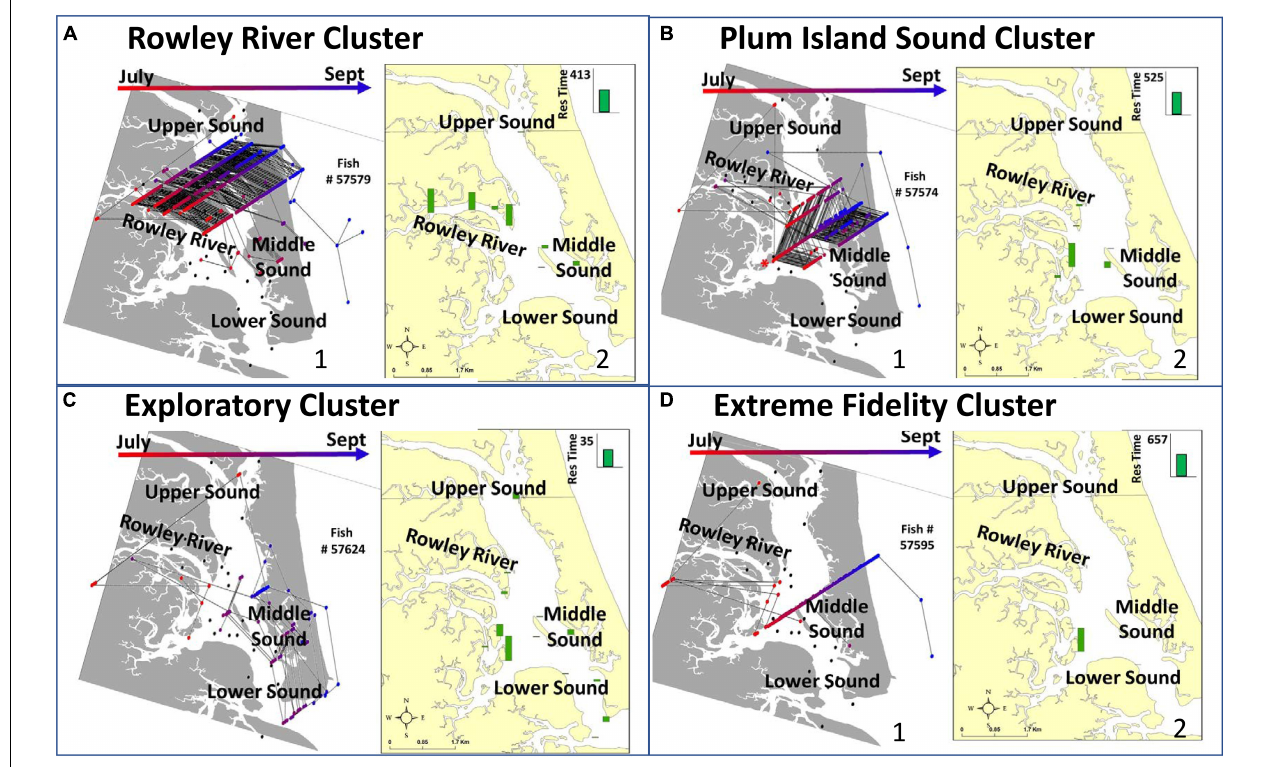
FIGURE 3 | Representative examples of individual fish in each of the four clusters (A–D) including: trajectories displaying detections and movements among receivers over the entire study period (A-1,B-1,C-1,D-1) and maps of the average residence time that this individual fish spends at each receiver location (A-2,B-2,C-2,D-2) . The arrows at the top and the corresponding dot colors in panels (A1–D1) show the direction that the fish moved through time. The green bars in panels (A2–D2) indicate receiver-specific residence time. When all detections (multicolor dots in A1–D1 ) are summed through time, the result is residence time (green bars in A2–D2 ). Both panels show the same data summarized in different ways. Both inform similarities within clusters and differences across clusters. Clusters include (A) Rowley River, (B) Plum Island Sound, (C) Exploratory, and (D) Extreme Fidelity groups. Trajectories are tracks of connected fish detections along the X , Y (latitude, longitude), and Z axis (time; July – bottom, September – top). The Z temporal data dimension comes out of the